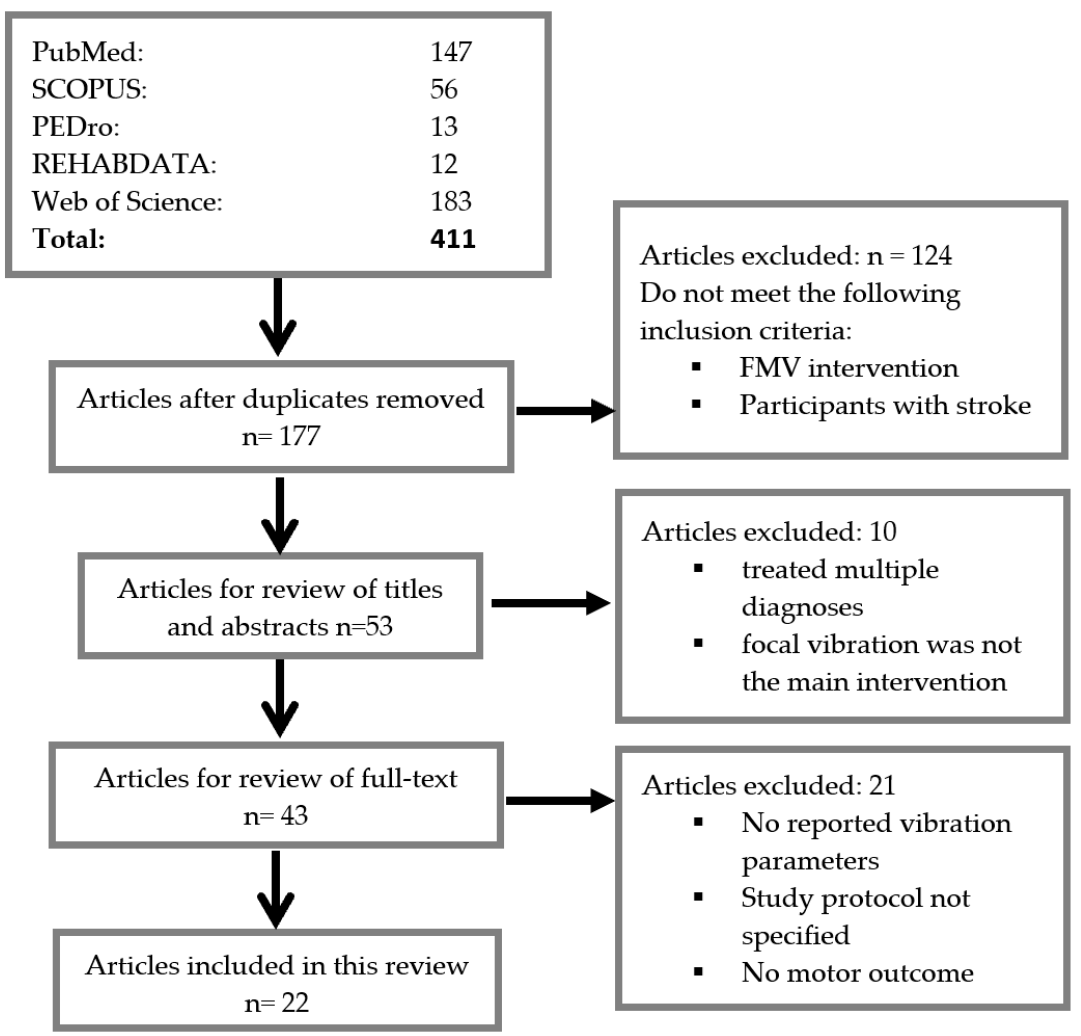
Figure 1 . Summary of literature review process Figure 1. Summary of literature review